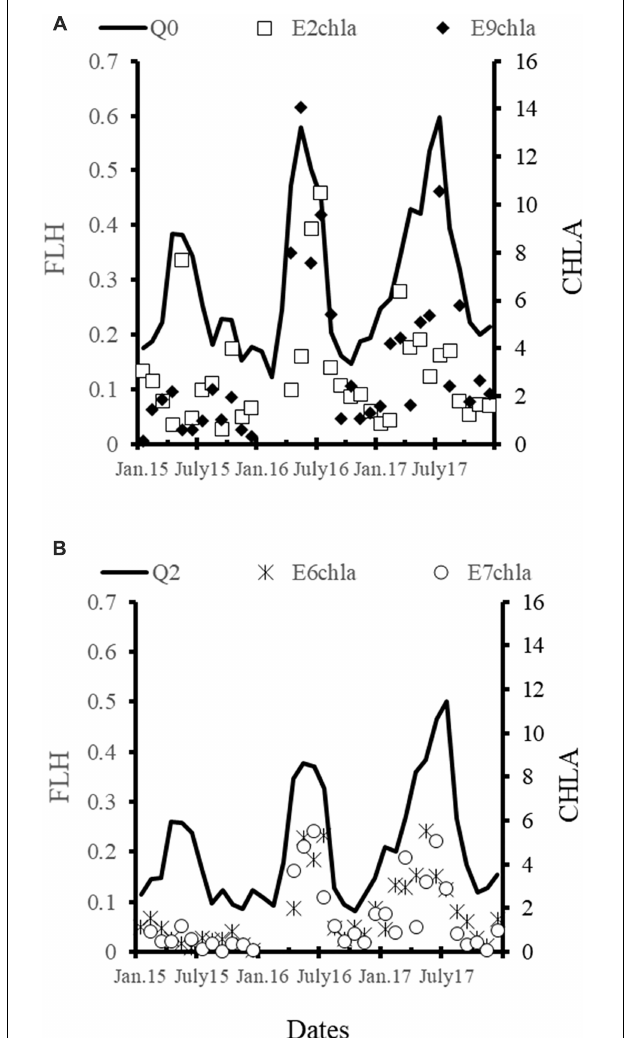
FIGURE 10 | Time series of the chlorophyll- a measured (mg m − 3 ) in situ and the fluorescence of the chlorophyll- a (mW cm − 2 µ m − 1 sr − 1 ) recorded by MODIS-Aqua satellite. (A) Quadrant 0 and chlorophyll data of E2 and E9; (B) Quadrant 2 and chlorophyll- a data of E6 and E7.